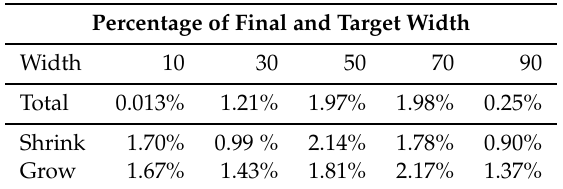
Table 10. Percentage from the final mean and target width in mm.